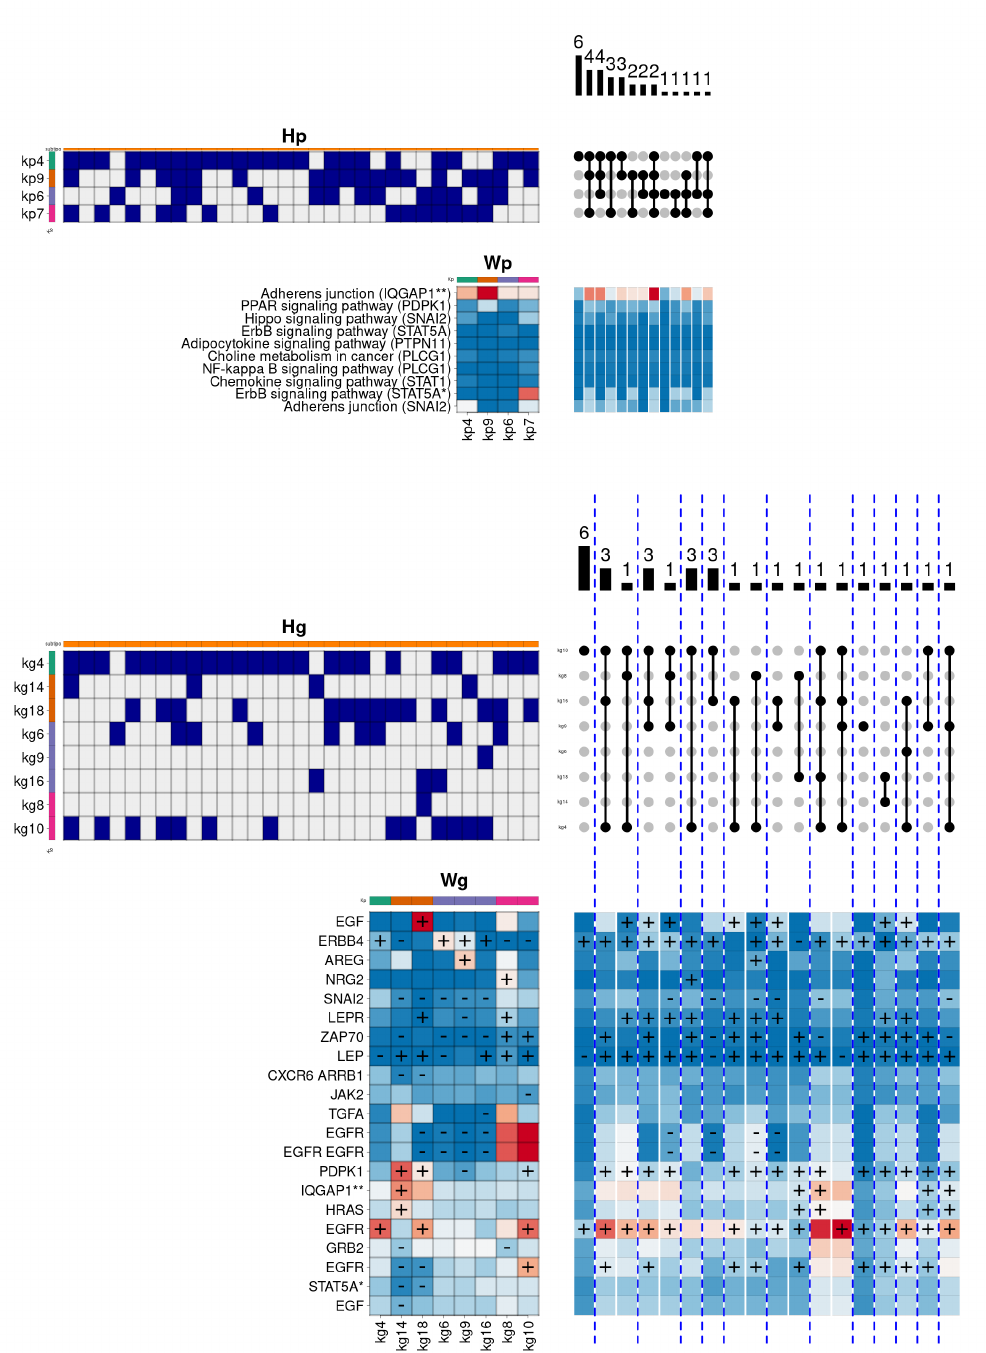
Figure 5. Graphical representation of the hierarchical model obtained for the biological function cellular response to epidermal growth factor stimulus , applied to the Her2 subtype. The most frequent combination observed at the pathway level relies on the kp4 component (coloured green), overactivat- ing two signalling cascades of the Adherens junction pathway. In the gene space, the kp4 component is associated with the kg4 component, having as relevant genes ERBB4 and EGFR , both belonging to the epidermal growth factor receptor